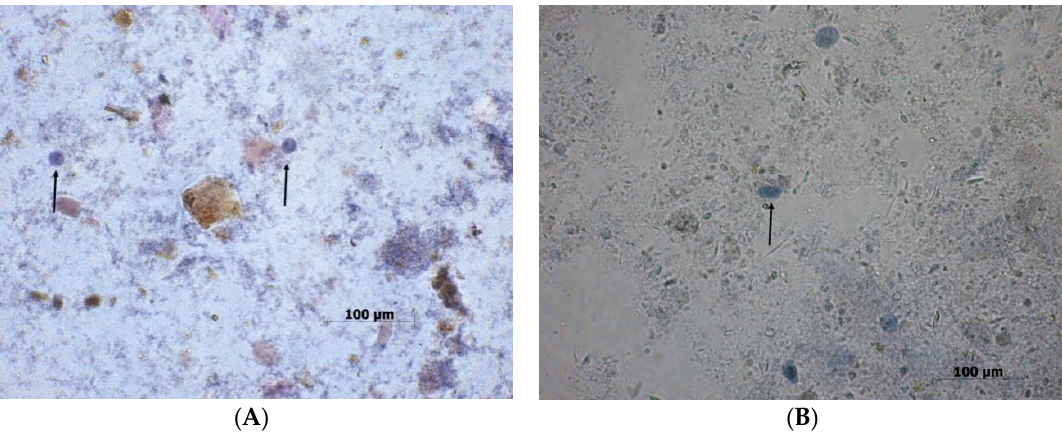
Figure 8. ( A ) Cyst of E. histolytica at 40x.( B ) Trophozoite of E. histolytica at 40x (all original